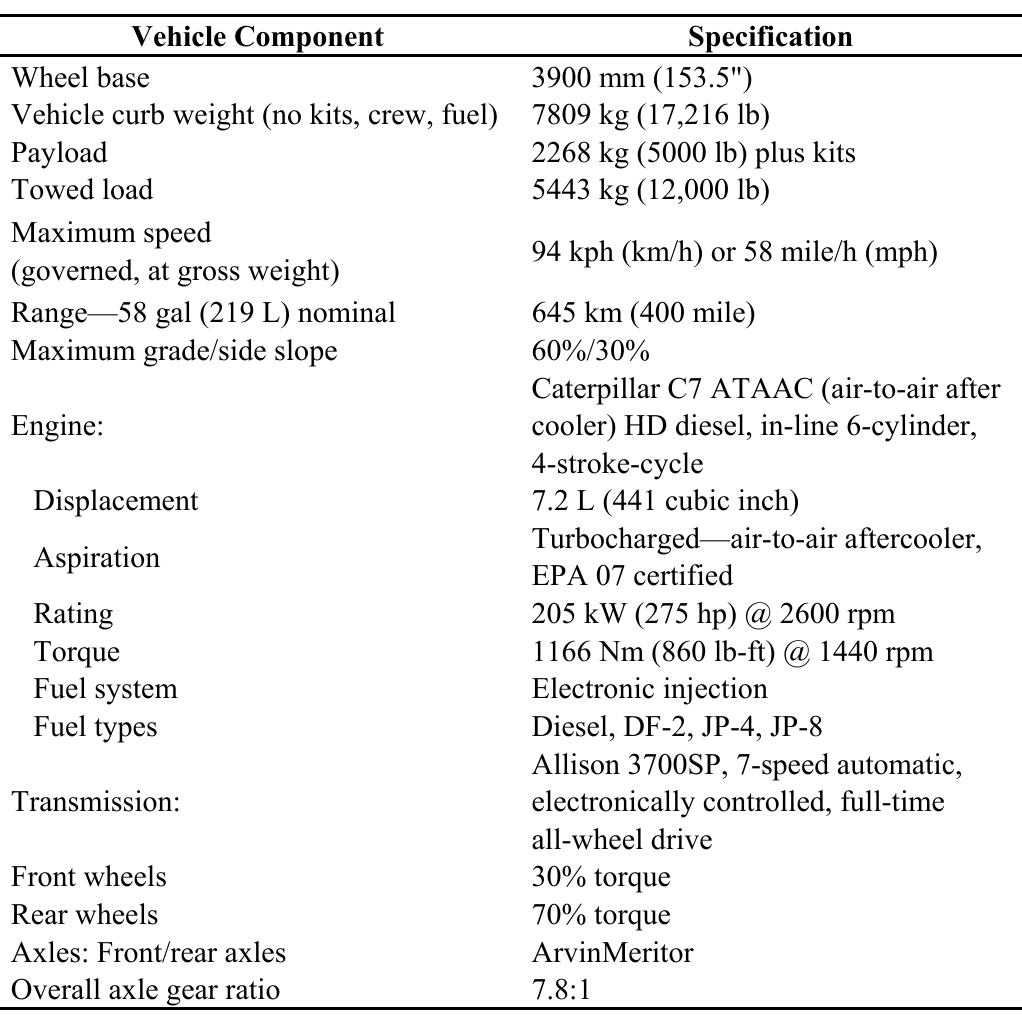
Table 1. LMTV M1078 A1 vehicle description